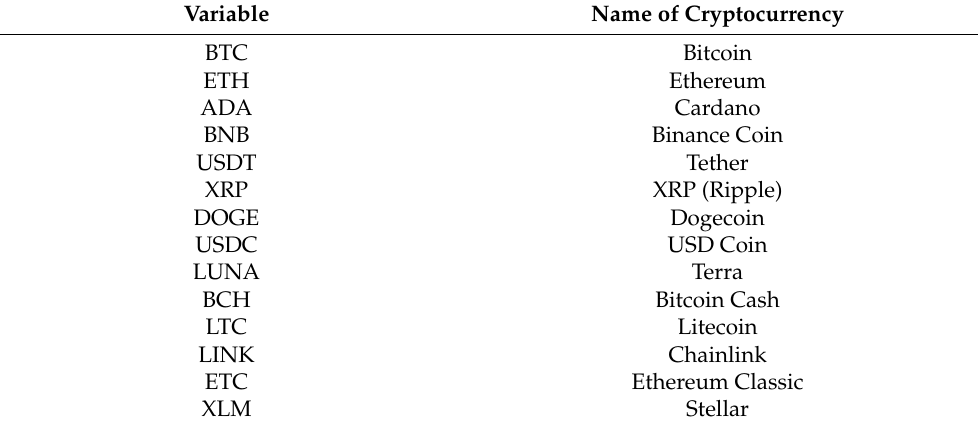
Table 1. Variable definitions.